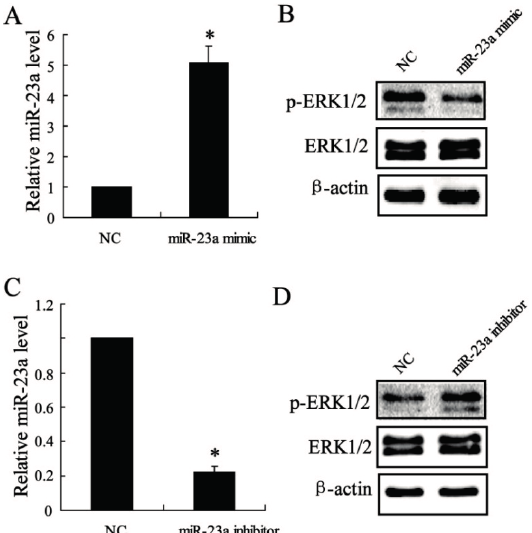
Figure 5. The effect of miR-23a on Extracellular signal-Regulated Kinase (ERK)1/2 expression in vitro. The relative miR-23a expression was quantified by real-time PCR ( A , C ); The p-ERK1/2 and ERK1/2 expression were detected by western blotting ( B , D ); Data were shown as mean ± SD; t -test of independent sample was used to analyze the difference between two groups; * considered as significant